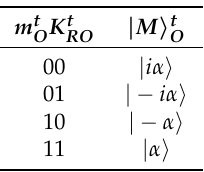
Table 2. The corresponding relations between m t